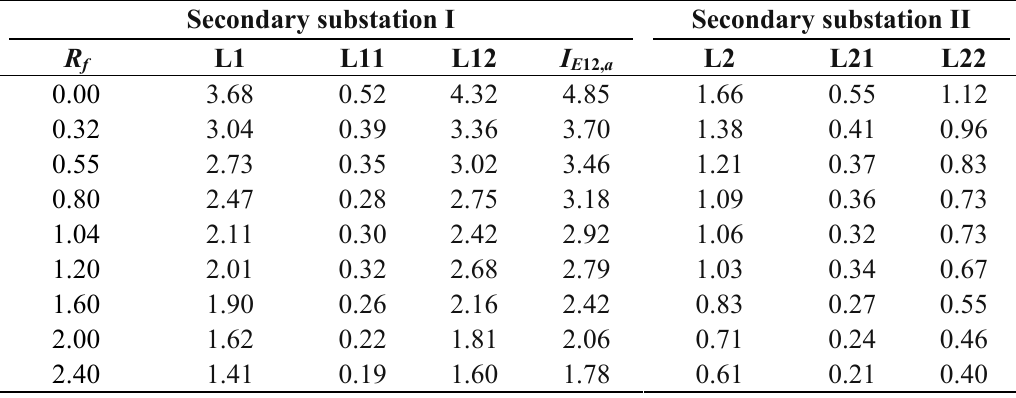
Table 10. Experimental results. Lines with and without load with different